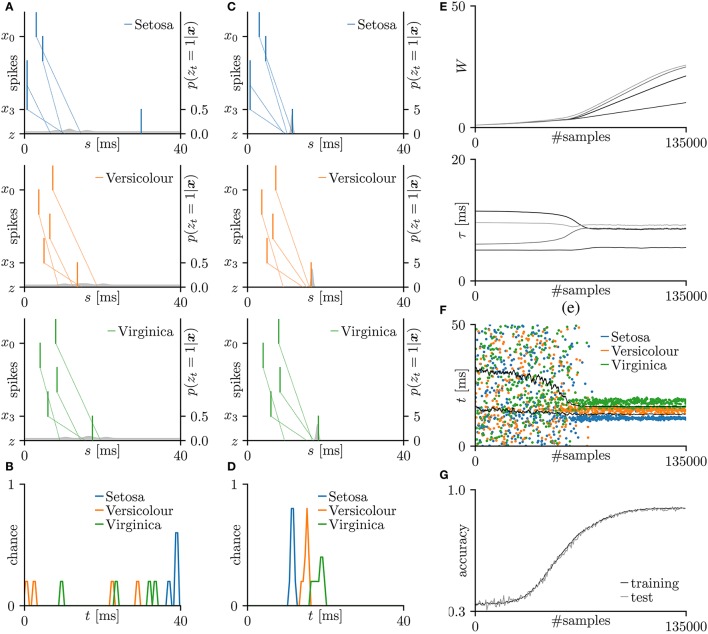
Results of SNN based on the Multinoulli-Bernoulli mixture model, evaluated on the iris flower dataset (Fisher, 1936). (A) Representative spatio-temporal spike patterns of Setosa (top panel), Versicolor (middle panel), and Virginica (bottom panel), and the post-synaptic spikes zt = 1 before learning. Vertical lines represent pre-synaptic spikes xis = 1 and post-synaptic spikes zt = 1 (the left vertical axes). Dotted lines denote transmission of the pre-synaptic spikes xis = 1 to the post-synaptic neuron z with conduction delays τi. Gray shaded areas denote the probability of eliciting a post-synaptic spikes zt = 1 per 1 ms (the right vertical axes). (B) Test distributions of the post-synaptic spike timings zt = 1 before learning. (C) Post-synaptic spike timings zt = 1 after learning, given the spatio-temporal spike patterns x in (A). (D) Test distributions of the post-synaptic spike timing zt = 1 after learning. (E) Trajectories of the synaptic weights Wi and conduction delays τi during the learning procedure. The darkest lines denote the values of the parameters W0 and τ0, and the lighter lines denote Wi and τi for i = 1, 2, … . (F) Random samples of the post-synaptic spike timings zt = 1. The black solid lines mark the decision boundaries between the three species. (G) Classification accuracy in the training and test datasets, each averaged over 100 trials.